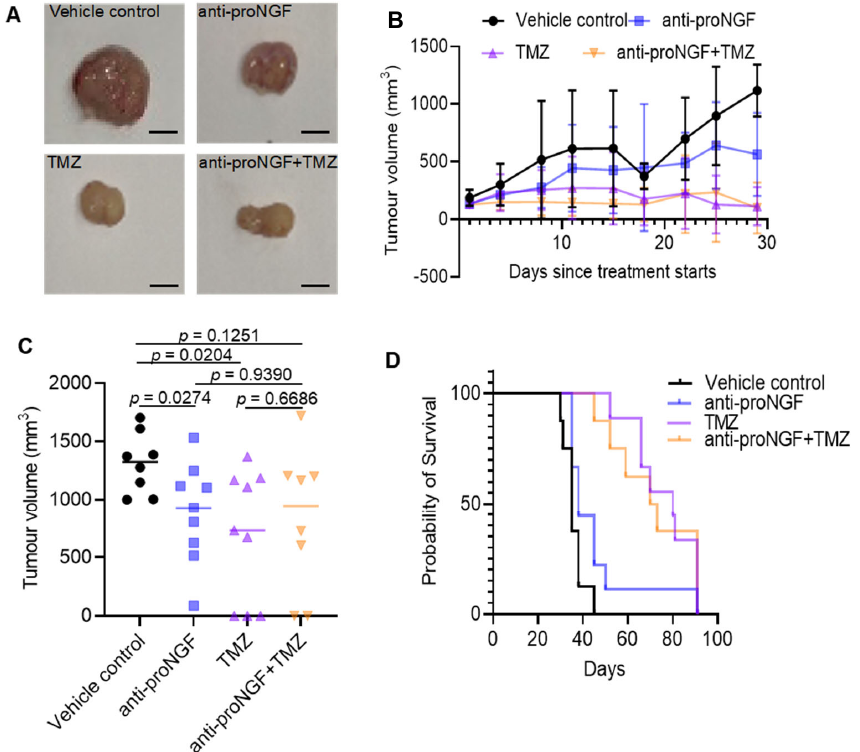
Figure 5. In vivo targeting of proNGF in a mouse model of GBM. A xenograft mouse model of GBM was used. The human U87MG cells were injected subcutaneously between the shoulder blades of BALB/c nude mice, along with blocking anti ‐ proNGF antibody (12 μ g, intratumoral injection, twice a week for 4 weeks) and/or TMZ (50 mg/kg body weight, IP daily for 5 days) treatment for a 4 ‐ week course. ( A ) Representative photographs of U87MG tumors excised from mice after 4 weeks of treatment. Scale bar, 5 mm. ( B ) The growth curves of U87MG tumors in BALB/c nude mice ( n = 9 for each group). ( C ) Comparison of volume of U87MG tumors harvested from mice treated with blocking anti ‐ proNGF antibody and/or TMZ for 4 weeks. ( D ) Kaplan ‐ Meier survival curves of BALB/c nude mice treated with anti ‐ proNGF antibody and/or TMZ. Vehicle control vs. anti ‐ proNGF: p = 0.0639; Vehicle control vs. TMZ: p < 0.0001; Vehicle control vs. anti ‐ proNGF + TMZ: p = 0.0003; Anti ‐ proNGF vs. anti ‐ proNGF + TMZ: p = 0.0160, TMZ vs. anti ‐ proNGF + TMZ: p = 0.8515. Data shown are the mean ± SD of tumors with 9 mice per treatment group. ProNGF: precursor for nerve growth factor, TMZ: Temozolomide. Vehicle control: PBS (vehicle control for anti ‐ proNGF) + 5%GMSO + 30% Polyethylene glycol 300 (PEG300) + double ‐ distilled H 2 O (vehicle control for TMZ); anti ‐ proNGF: anti ‐ proNGF + 5%GMSO + 30% PEG300 + double ‐ distilled H 2 O (vehicle control for TMZ); TMZ: TMZ + PBS (vehicle control for anti ‐ proNGF); anti ‐ proNGF + TMZ: anti ‐ proNGF + TMZ.